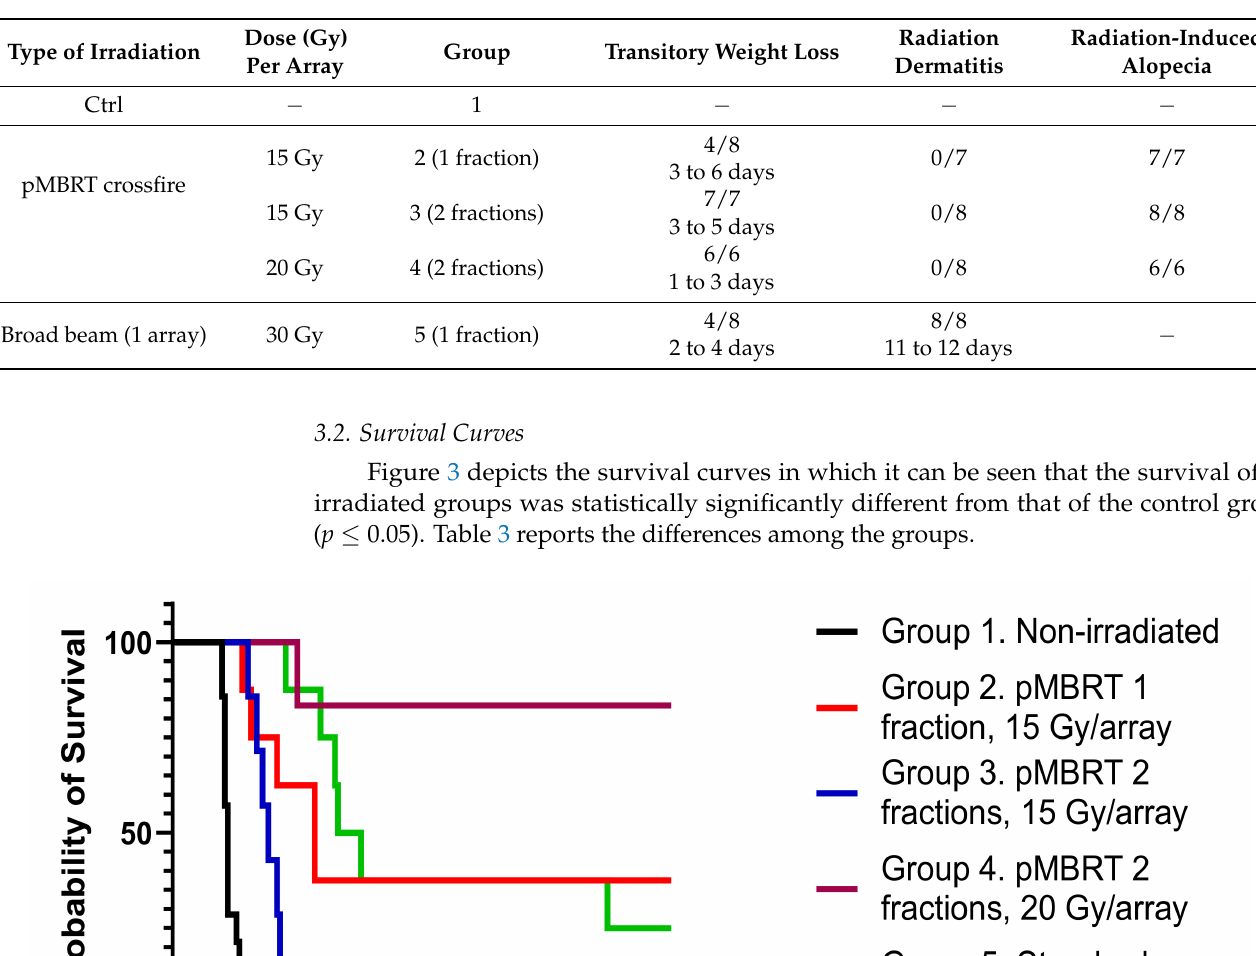
Table 2. Summary of clinical symptoms shown in the experimental groups.